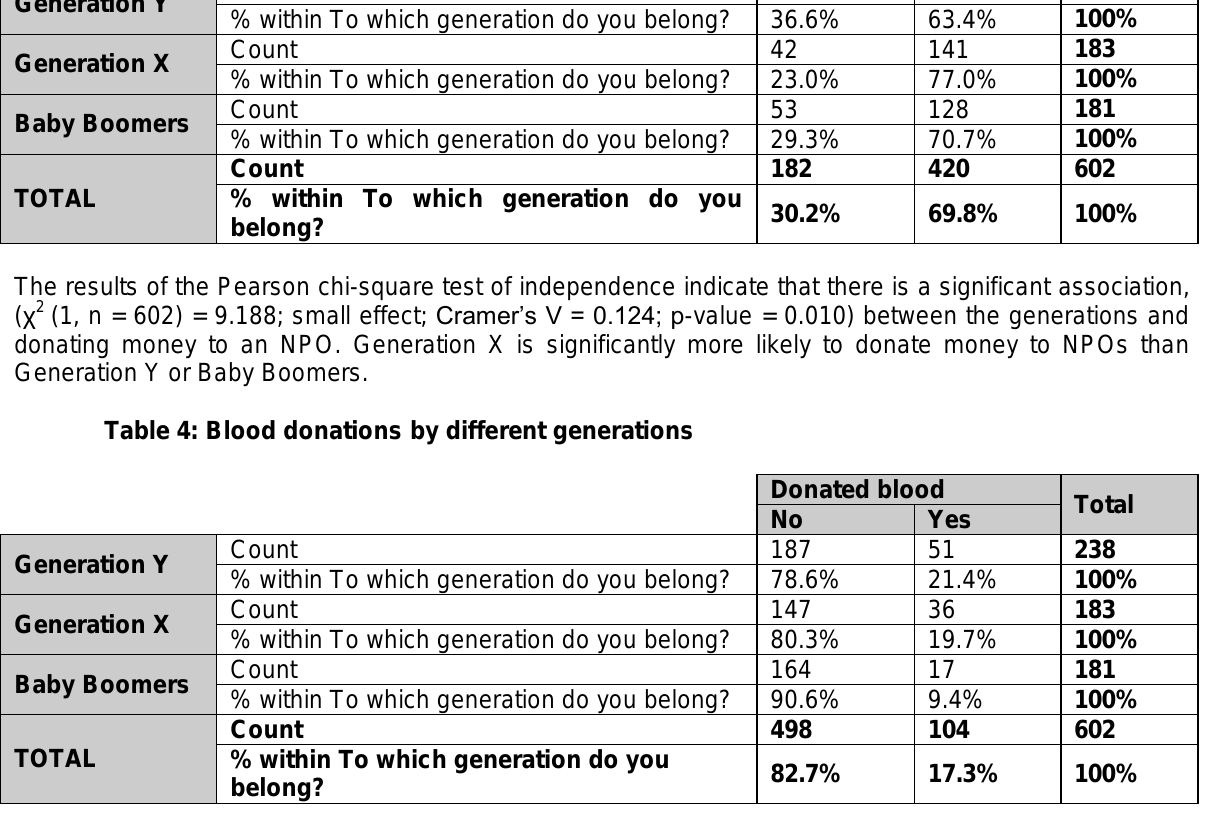
Table 3: Money donations by the different generations Generation Y